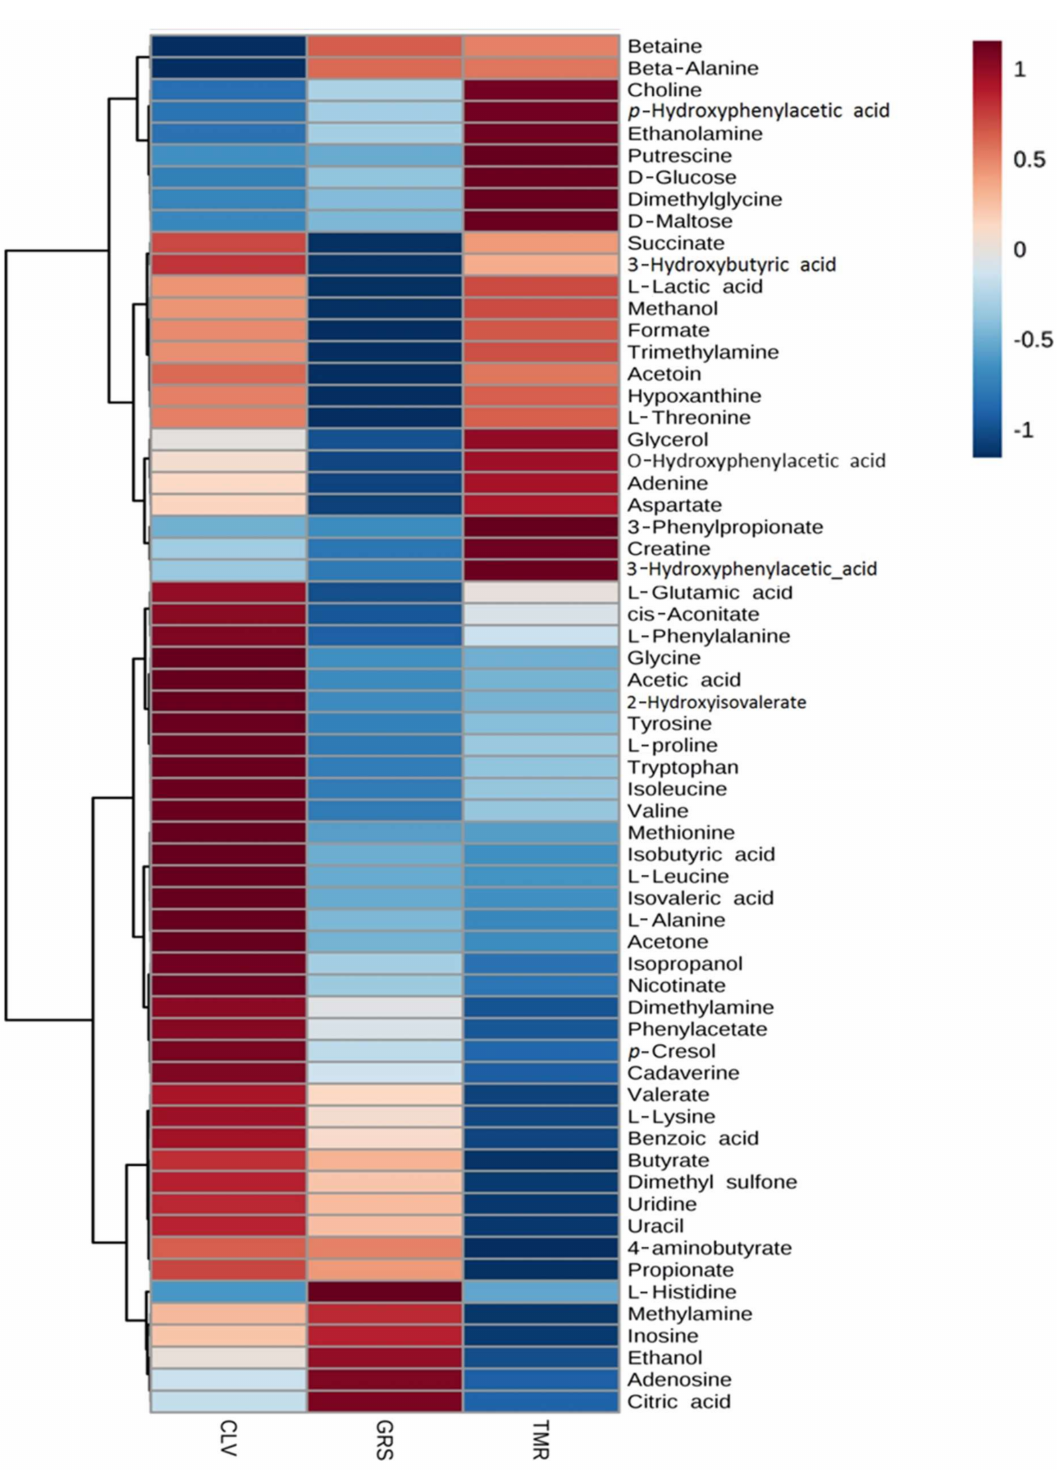
Figure 3. Hierarchical clustering analysis (heatmap) of average rumen fluid metabolites from lactating dairy cows fed diets consisting of total mixed ration (TMR), perennial ryegrass (GRS), or perennial ryegrass and white clover (CLV), as determined by 1 H-NMR. The degree of positive and negative correlation of metabolite to dietary system is indicated by +1 (red) to − 1